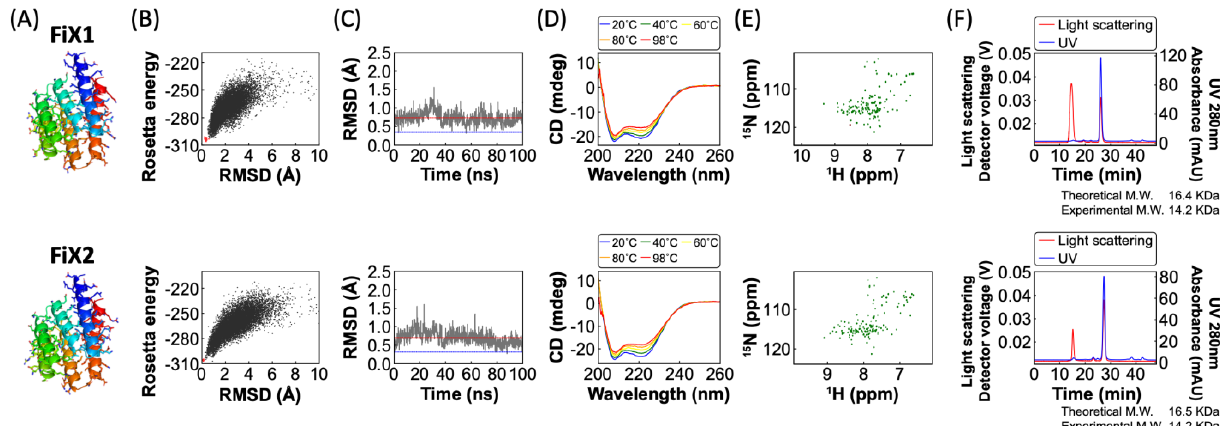
Figure 3. Characterization of the de novo designed fusion partner proteins without A 2A R. De novo designed fusion partner proteins, FiX1 (upper) and FiX2 (lower). ( A ) Computational models. ( B ) The energy landscape of each designed protein obtained from Rosetta folding simulations [17]. Each dot represents the lowest energy structure obtained from an independent trajectory starting from an extended chain (black) or the design model (red), the x- axis shows the Cα RMSD from the design model, and the y-axis shows the Rosetta full-atom energy. ( C ) Structural fluctuations of the N- and C-terminal helices in the MD simulation, starting from each design model. The main-chain RMSD of the N- and C- terminal helices of each snapshot structure during a MD trajectory against TM5 and TM6 of A 2A R is shown along the time course. (Red and blue lines are the averaged and initial RMSD values, respectively.) ( D ) Far-ultraviolet CD spectra at various temperatures from 20 to 98 °C. ( E ) Two-dimensional 1 H – 15 N HSQC spectra at 25 °C and 600 MHz (in parts per million, p.p.m). ( F ) Size-exclusion chromatograms combined with multi-angle light scattering (SEC-MALS) demonstrate that these designed proteins are monomeric in solution. M.W. stands for molecular weight.